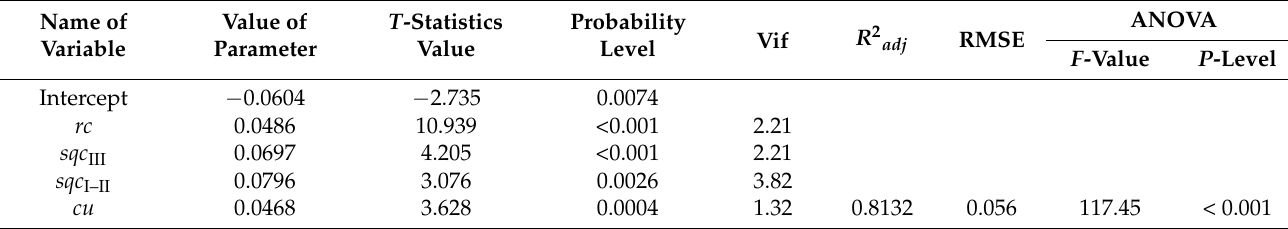
Table 4. Parameters and basic statistics of Equation